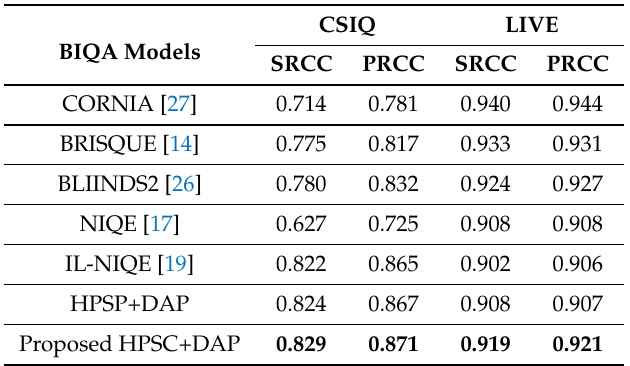
Table 3. Evaluation results of different methods on the CSIQ and the LIVE databases. The best results are highlighted in bold.